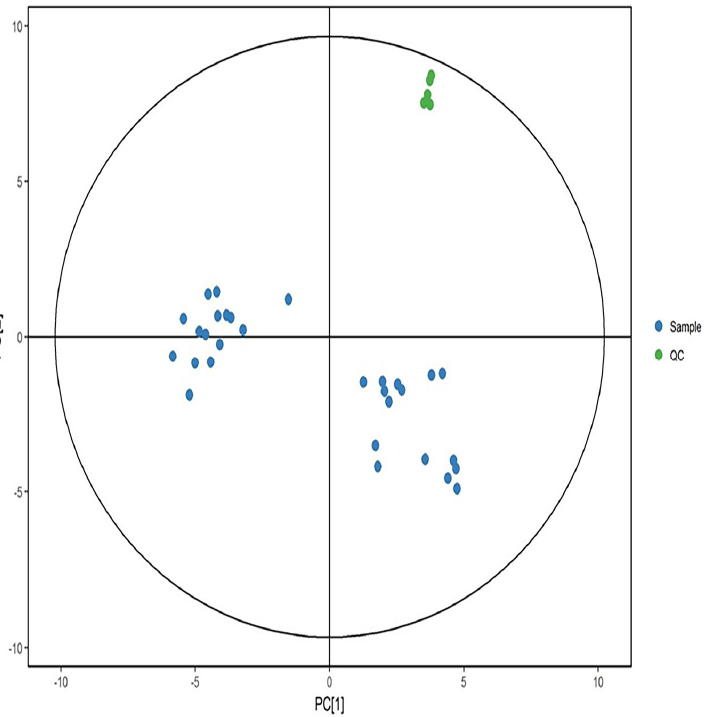
3 Figure 3. PCA score in positive ion mode. Green dots represent quality control samples, and blue dots represent study samples.